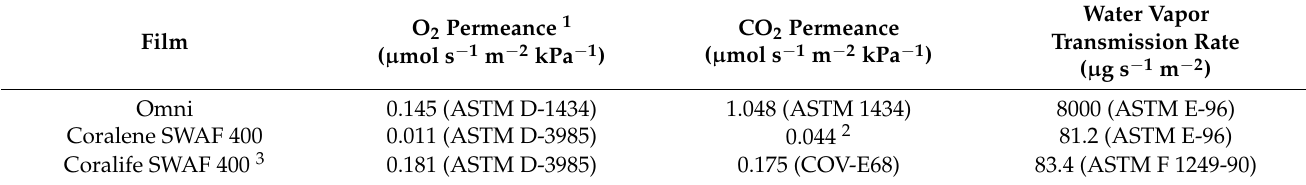
Table 1. Barrier properties of the plastic films used and method used for